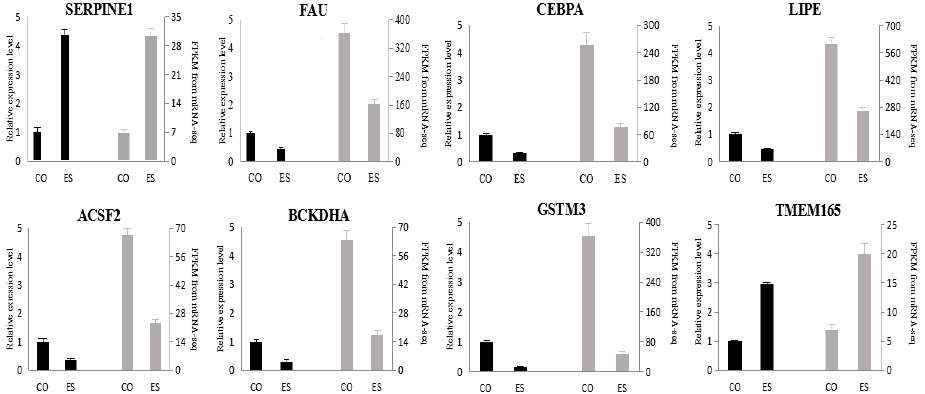
Figure 2. Validation of the SERPINE1 , FAU , CEBPA , LIPE , ACSF2 , BCKDHA , GSTM3 and TMEM165 genes by qPCR analysis.